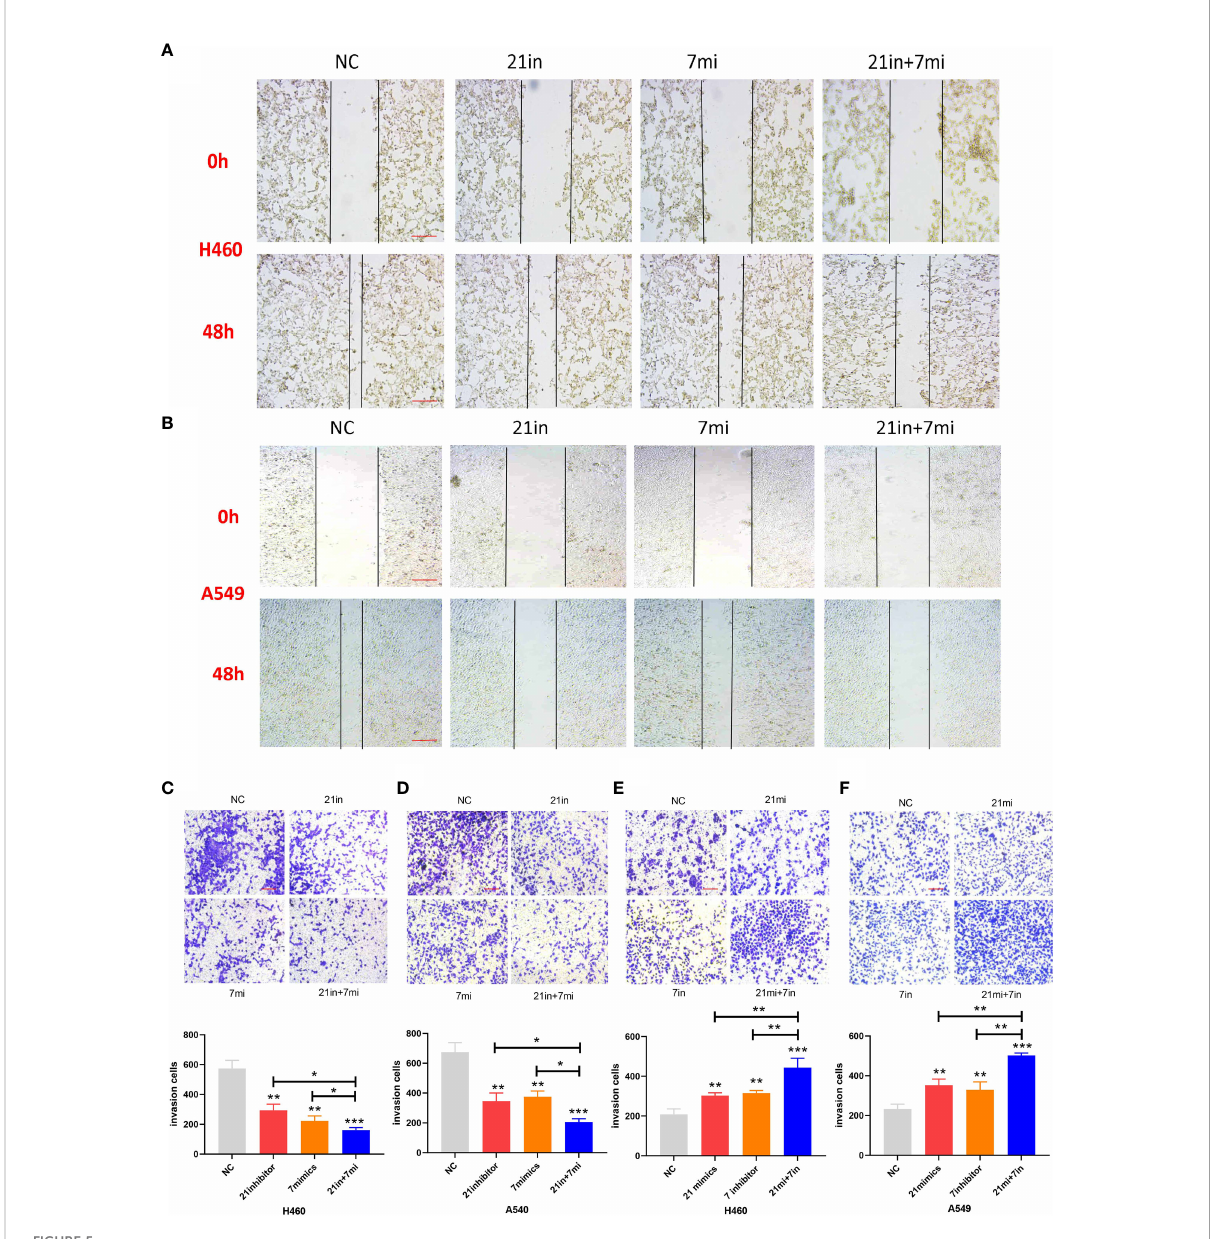
FIGURE 5 Wound-healing and Transwell assays of lung cancer cell lines. (A, B) Relative migrating areas after transfection of miR-21/let-7 inhibitors or mimics at 0 and 48 h. (C – F) Relative invasion areas after transfection of miR-21/let-7 inhibitors or mimics in lung cancer cell lines (scale bar: 100 m m; * p < 0.05; ** p < 0.01; *** p <